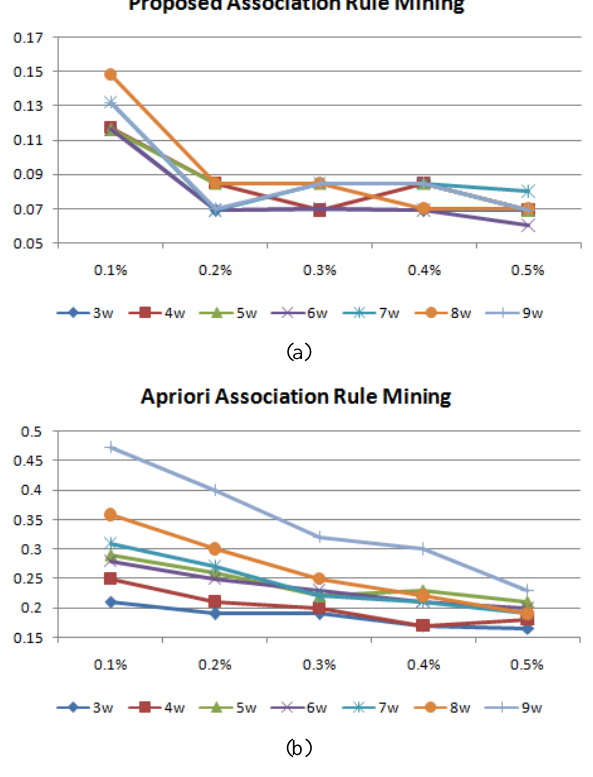
Figure 3. Forest retrieval results for WorldView-2 image dataset (a) proposed method (b) DT-CWT method